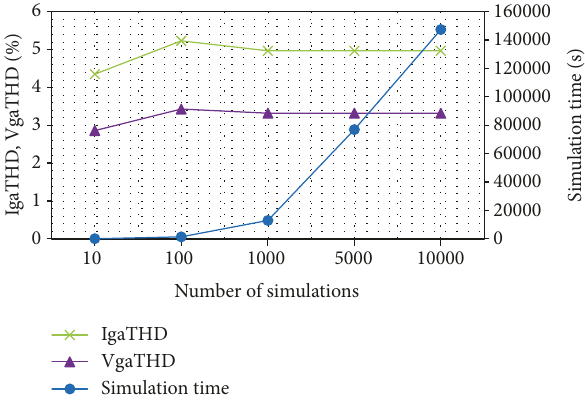
Figure 3: THD result for 2 VSCs connected in